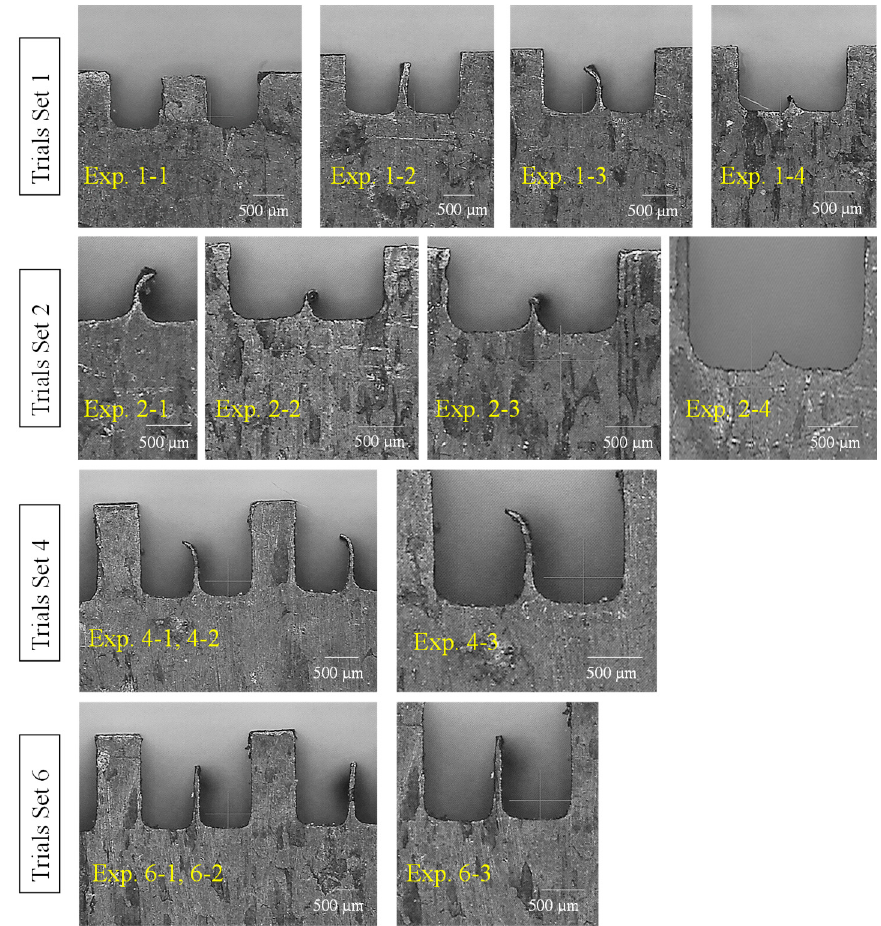
Figure 2. Experimental results of different trial sets for determining the minimum inter-channel fin thickness.